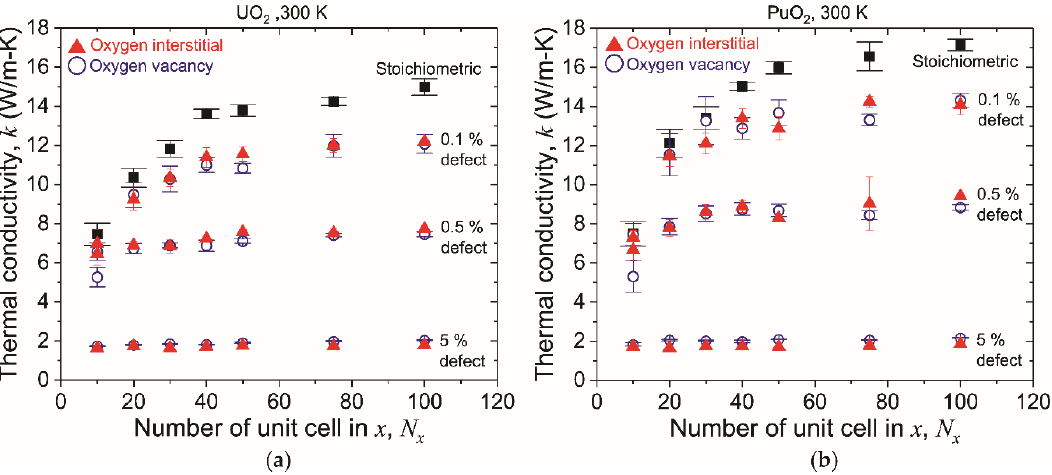
Figure 5. ( a ) Thermal conductivity of stoichiometric UO 2 and UO 2 with various defects. ( b ) Thermal conductivity of stoichiometric PuO 2 and PuO 2 with various defects.